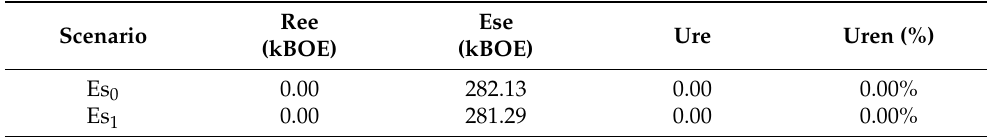
Table 23. Use of RE in the supply of electricity.